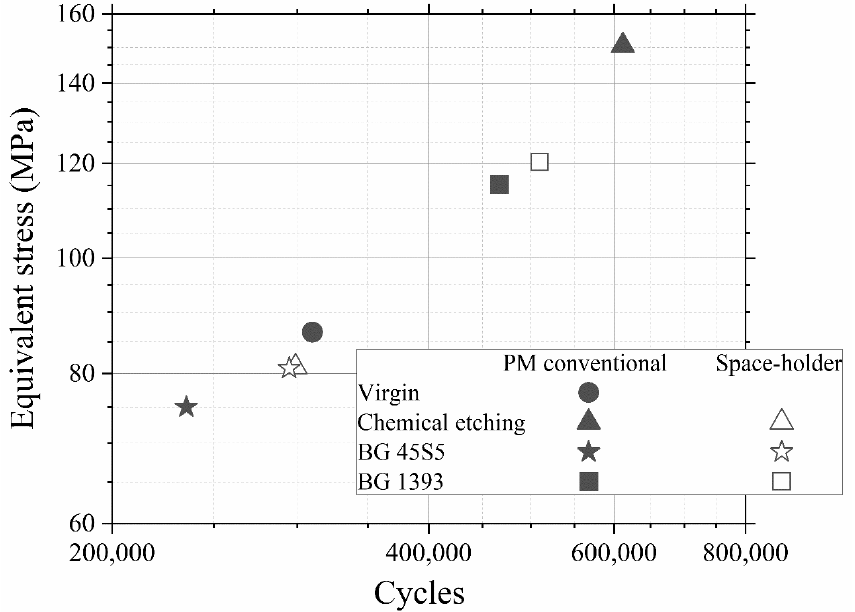
Figure 5. Equivalent stress vs number of cycles. Note: Superficially modified dental implants could guarantee the mechanical requirements (the cortical bone tissue presents a fatigue strength at 10 7 cycles of 27–35 MPa [40]).